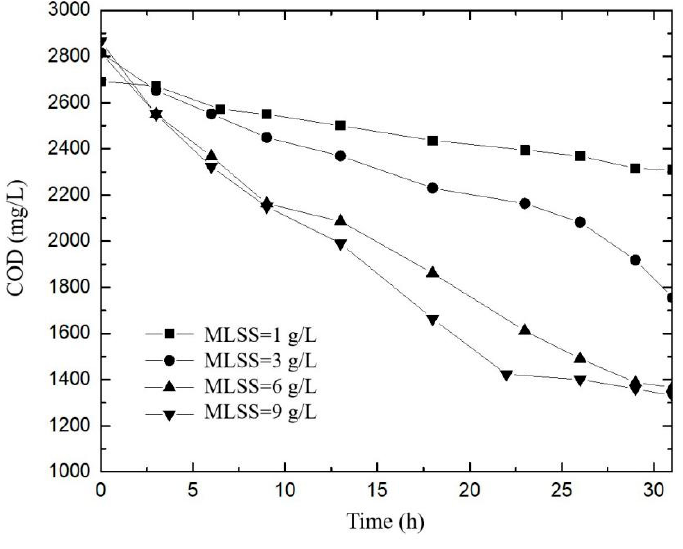
Figure 2. COD changes under different MLSS.